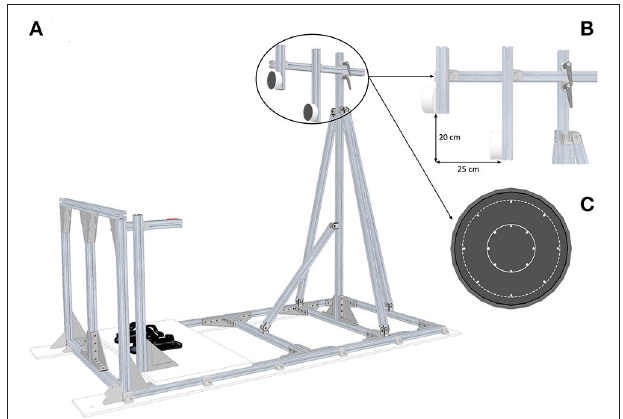
FIGURE 1 | Experimental setup. (A) Global view of the pointing structure including targets, start push-button and footstraps. (B) Side view of the targets which illustrates the position of the Far targets relative to the Close targets. (C) Front view of the two target sizes: the solid line area represents the Small targets (Ø 4 cm) and the dotted line area represents the Large targets (Ø 10